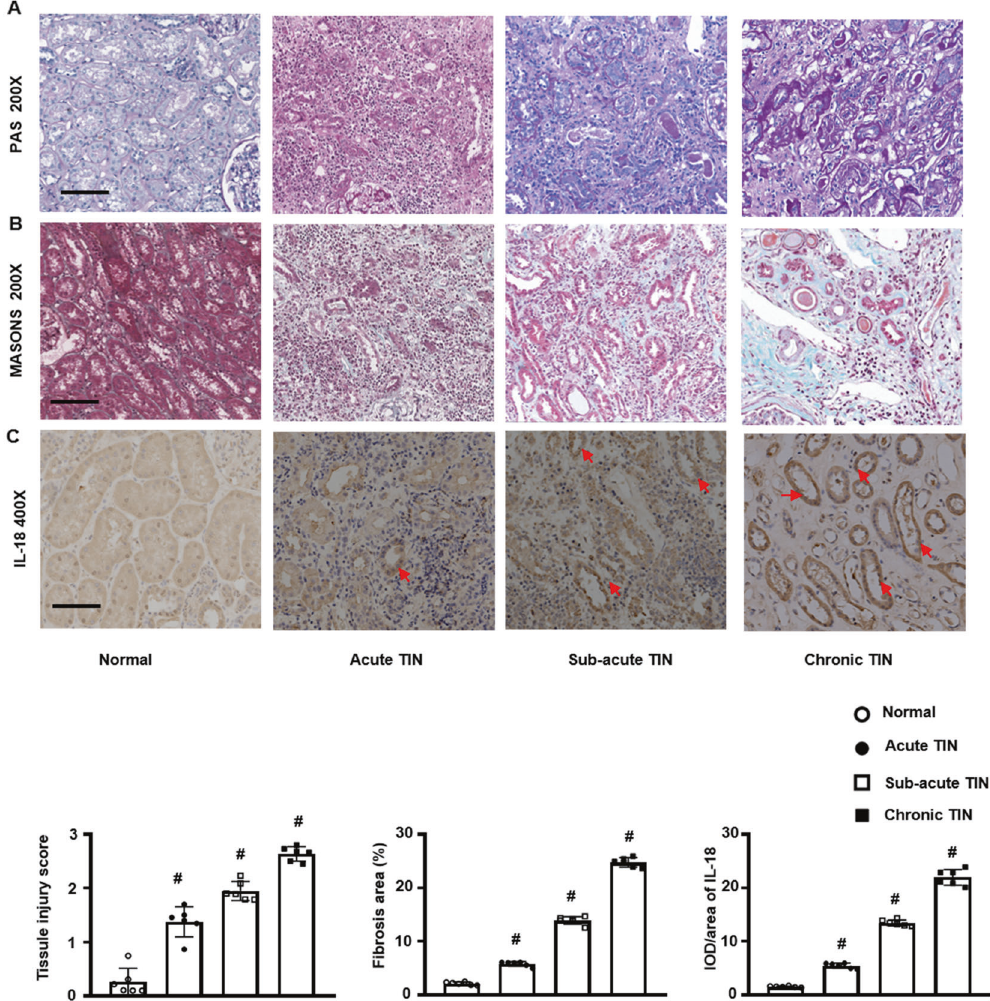
Fig. 8 IL-18 increased in renal biopsies from patients with interstitial nephritis (TIN). A PAS staining. B Masson staining. C IHC staining of IL- 18 (red arrow). Magni fi cation, 200×, bar = 200